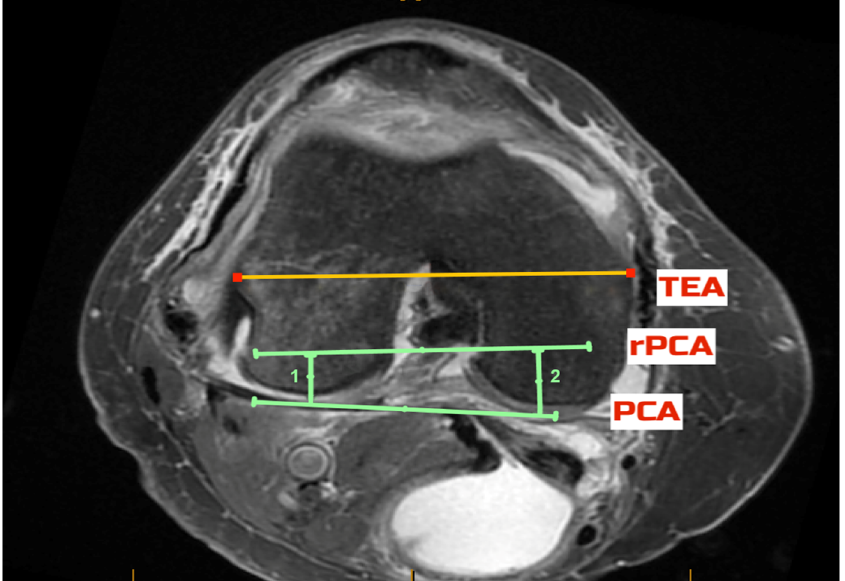
Figure 3. The transepicondylar axis (TEA—yellow line) was defined as the line connecting the most prominent medial and lateral aspects of the respective epicondyles (yellow line). The angles between the posterior condylar axis (PCA—lower green line) and the TEA (PCA/TEA angle), between the prosthetic posterior condylar axis (rPCA, top green line) and the PCA (rPCA/PCA angle) and between the rPCA and the TEA (rPCA/TEA angle) were measured in each case. The green lines 1 and 2 designate the posterior condylar resection depth at time of surgery.